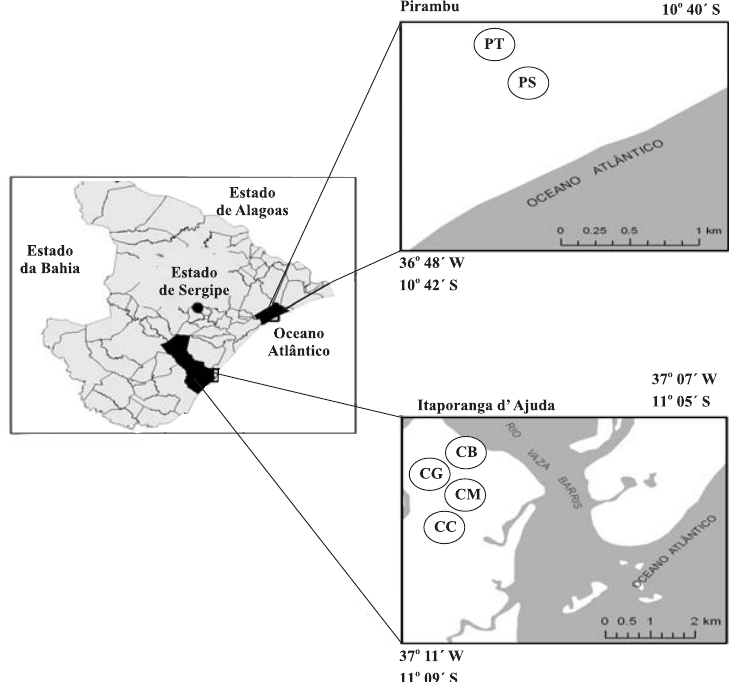
Figura 1. Localização dos sítios estudados, municípios de Itaporanga d’Ajuda e Pirambu, no litoral do Estado de Sergipe. CM: Caju, mata; CG: Caju, capim-gengibre; CB: Caju, coqueiral do banco de germoplasma; CC: Caju, capoeira; PT: Pirambu, mata de topo; Pirambu, mata de